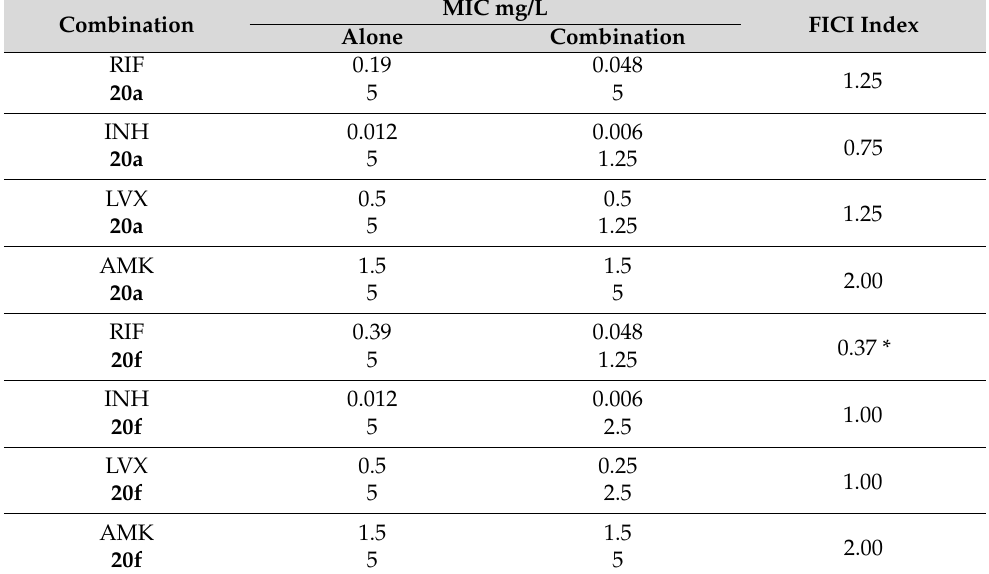
Table 4. MIC values of the compounds before and after combinations with antibiotics and the FICI index in M. tuberculosis